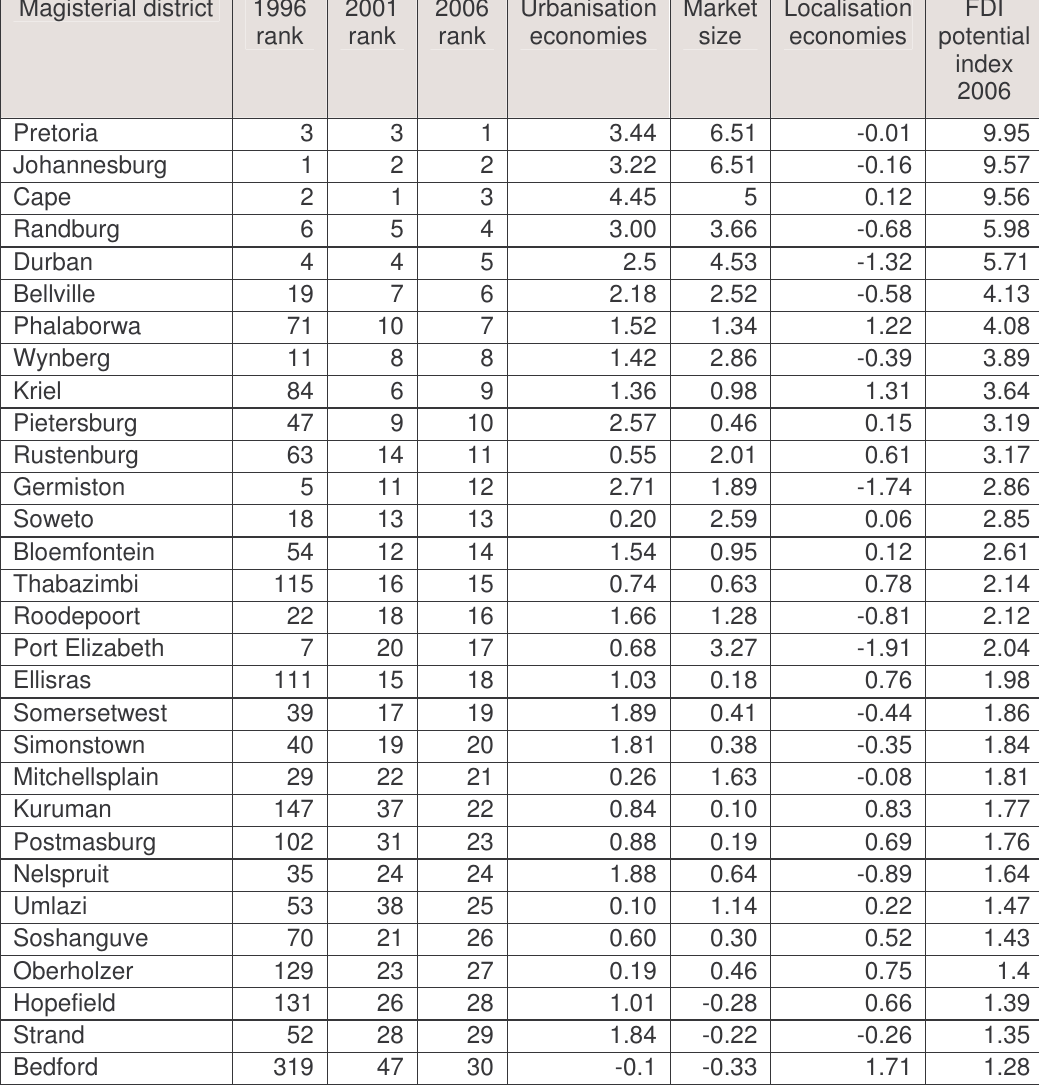
Table 7: FDI potential rankings in 1996, 2001 and 2006 Magisterial